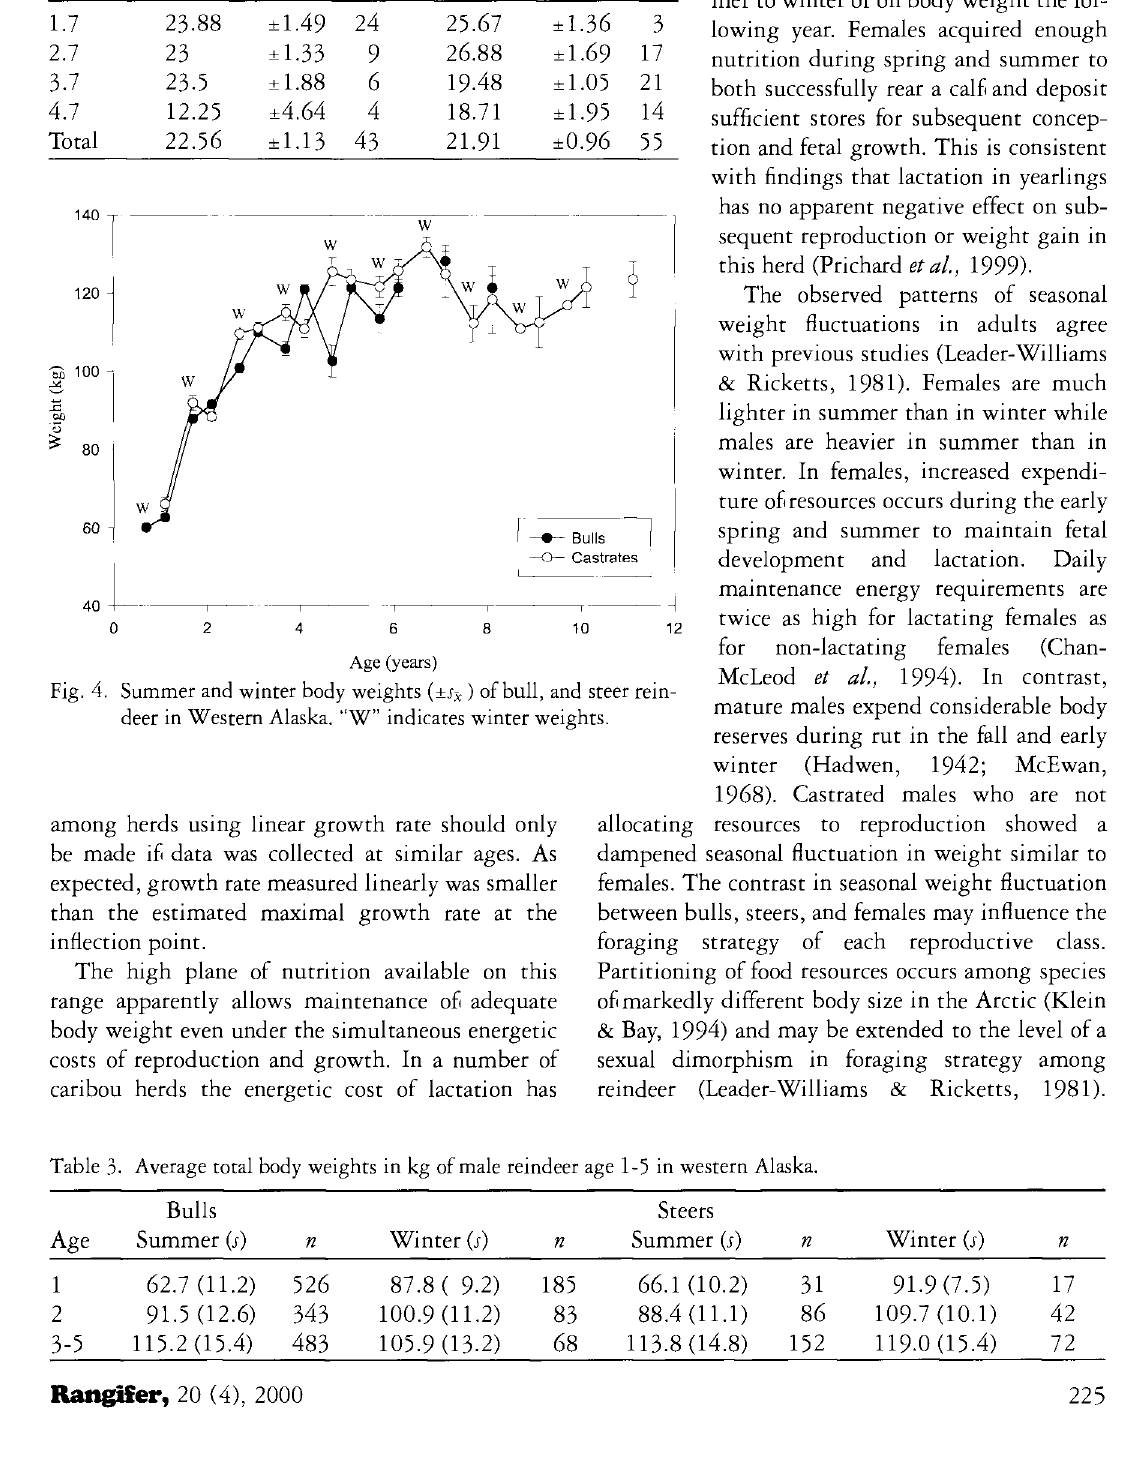
Table 2. Weight gain in kg from summer handling in 1988 to winter handlings in January of 1989, of female reindeer with an udder and without an udder during the summer handling.